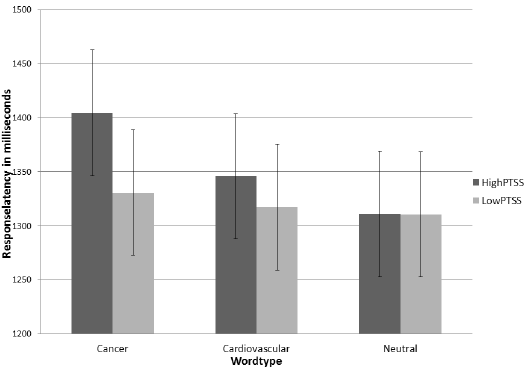
Fig 1. The effect of word-type and group on response latency in the emotional Stroop task (error bars represent standard errors